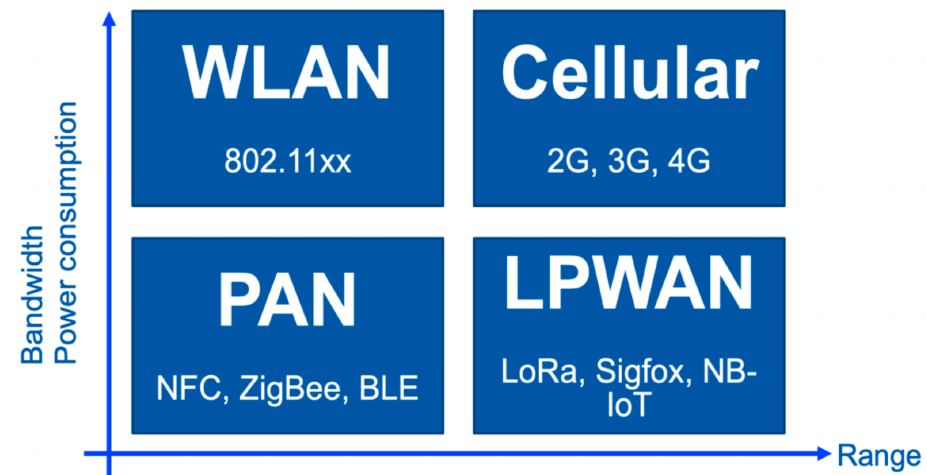
Figure 1. Wireless